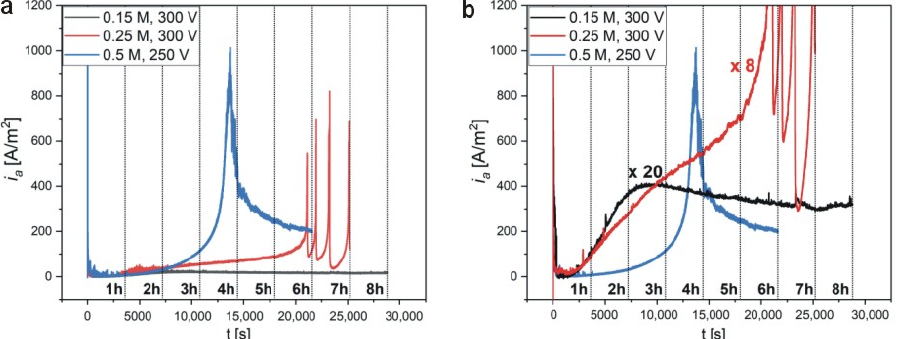
Figure 3. i a ( t ) curves recorded during anodization of aluminium at temperature of 5 °C in various malic acid concentrations and for various anodization times ( a ); the same i a ( t ) curves with amplified intensities for the samples anodized in 0.15 and 0.25 M malic solutions ( b ) (vertical lines indicate the subsequent hours of anodization).